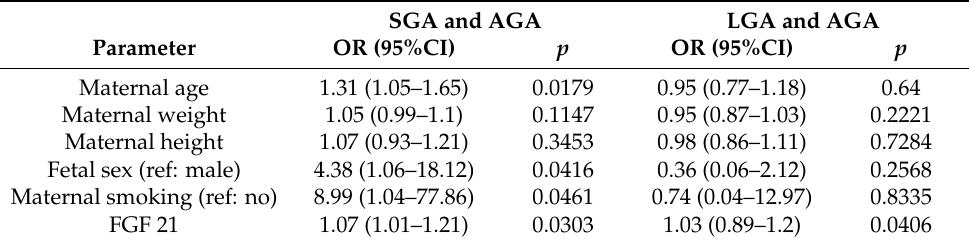
Maternal smoking (ref: